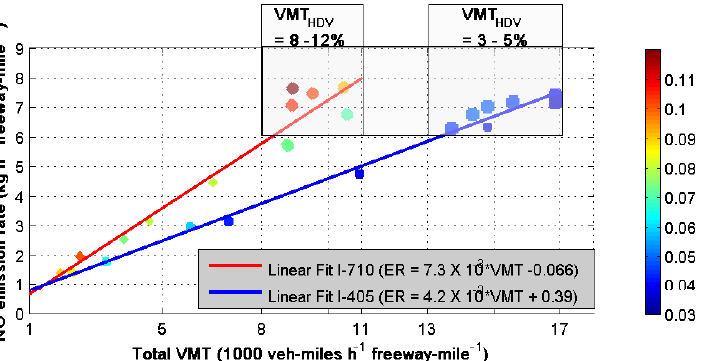
Fig. 6. Comparison of NO emission rates for a low (I-405) and high (I-710) HDD fraction freeway. The color bar indicates the fraction of total VMT attributable to